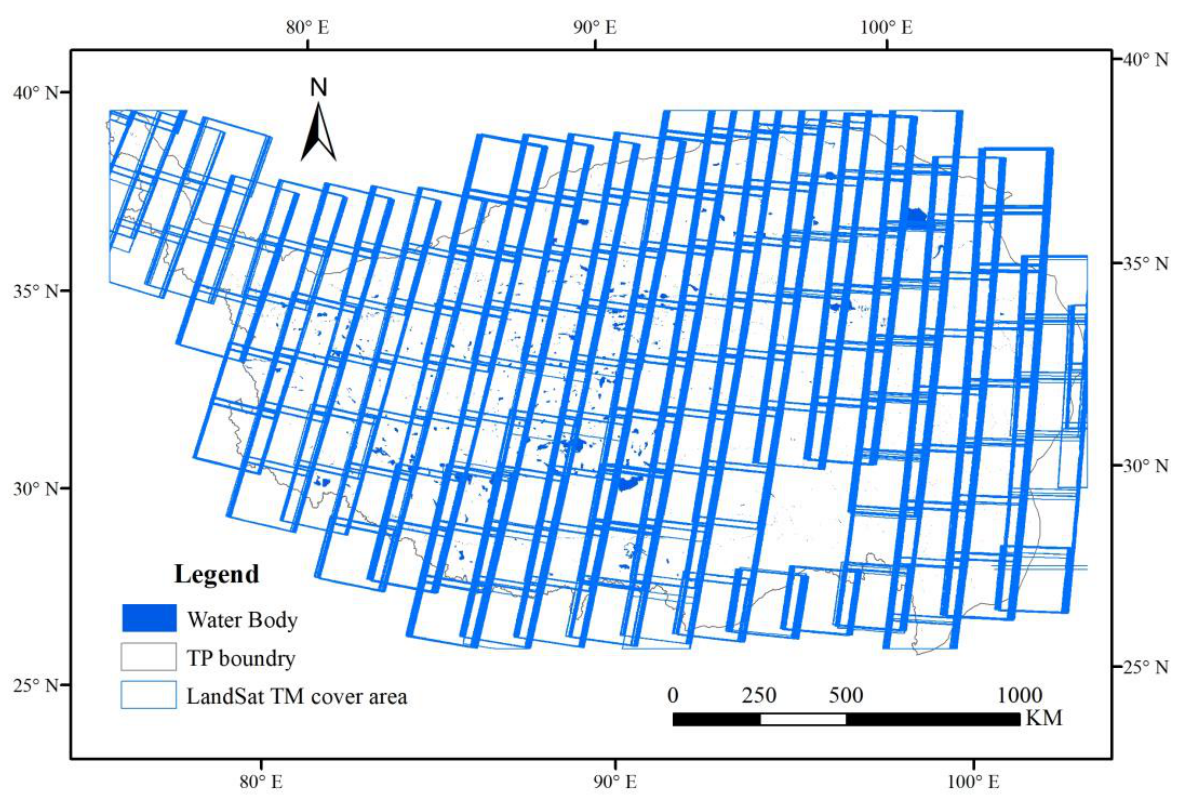
Figure 2. The cover area of 4868 Landsat TM used in this study. The blue rectangles were the boundaries of the Landsat TM images.